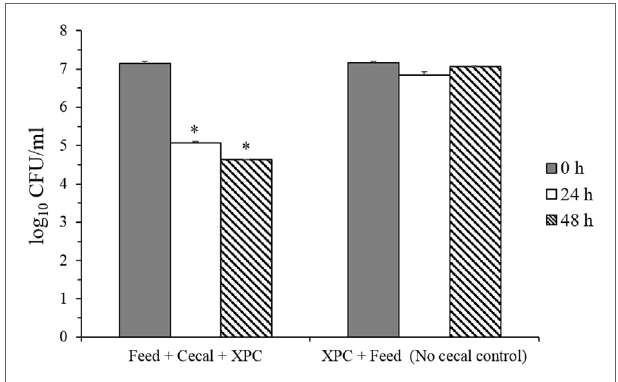
FigUre 4 | Salmonella Typhimurium survival in feed + cecal + fermentation metabolites of Original XPc and in control anaerobic cultures lacking cecal contents . Asterisks indicate significant difference ( P < 0.005) from the corresponding control.